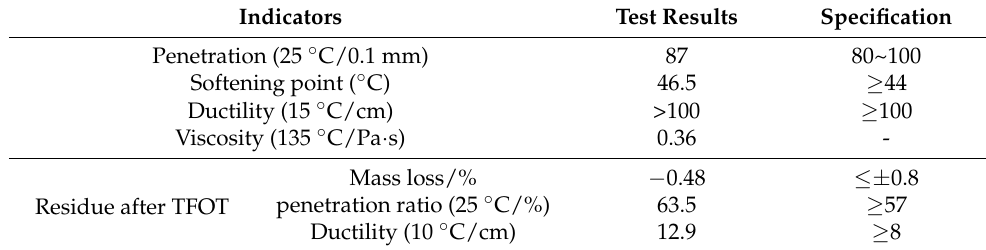
Table 2. The technical indicators of virgin